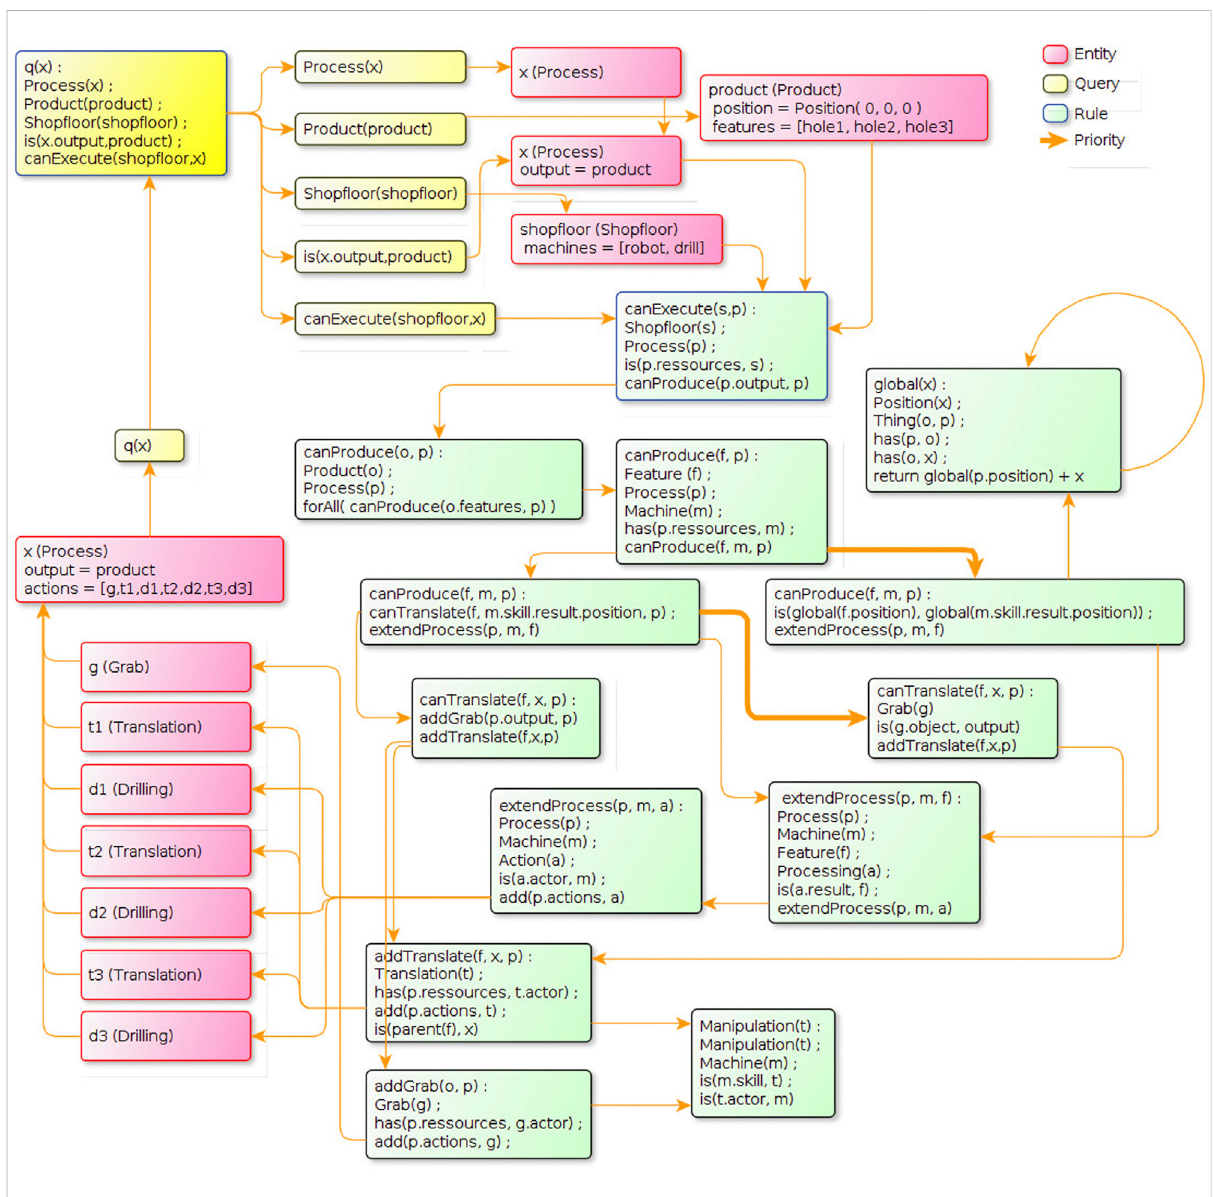
FIGURE 13 Fully unrolled processing of a query to the reasoning